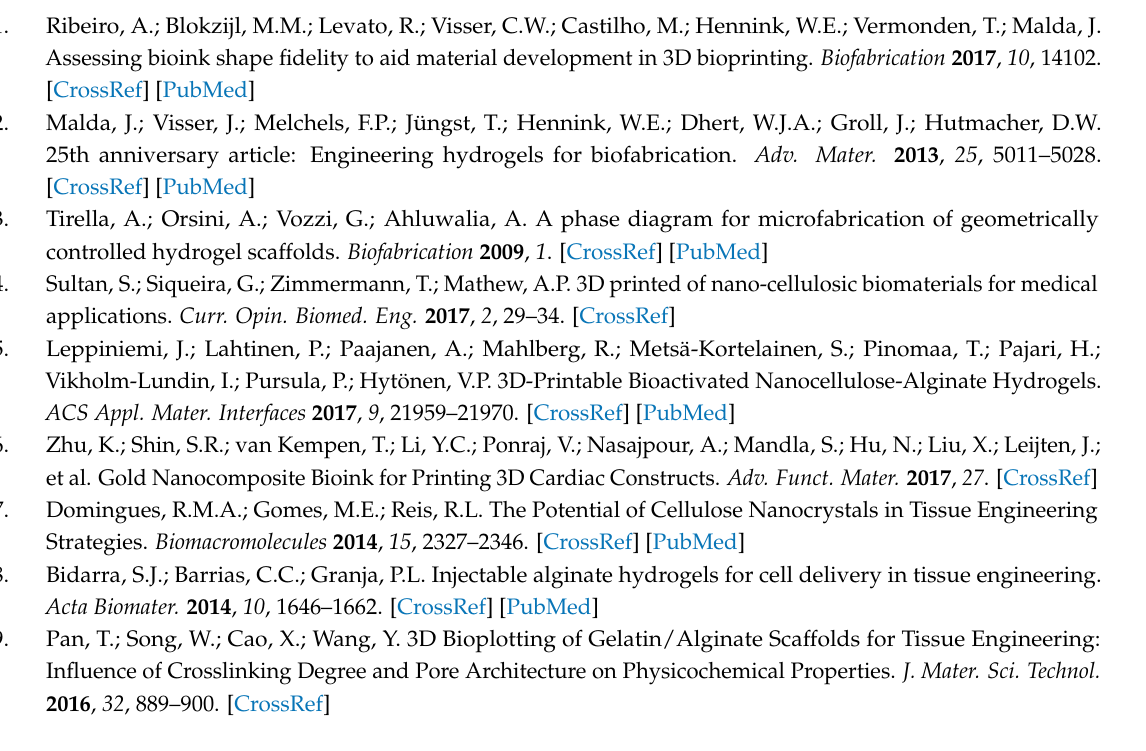
Figure S1: Compression modulus of bulk hydrogels during the degradation